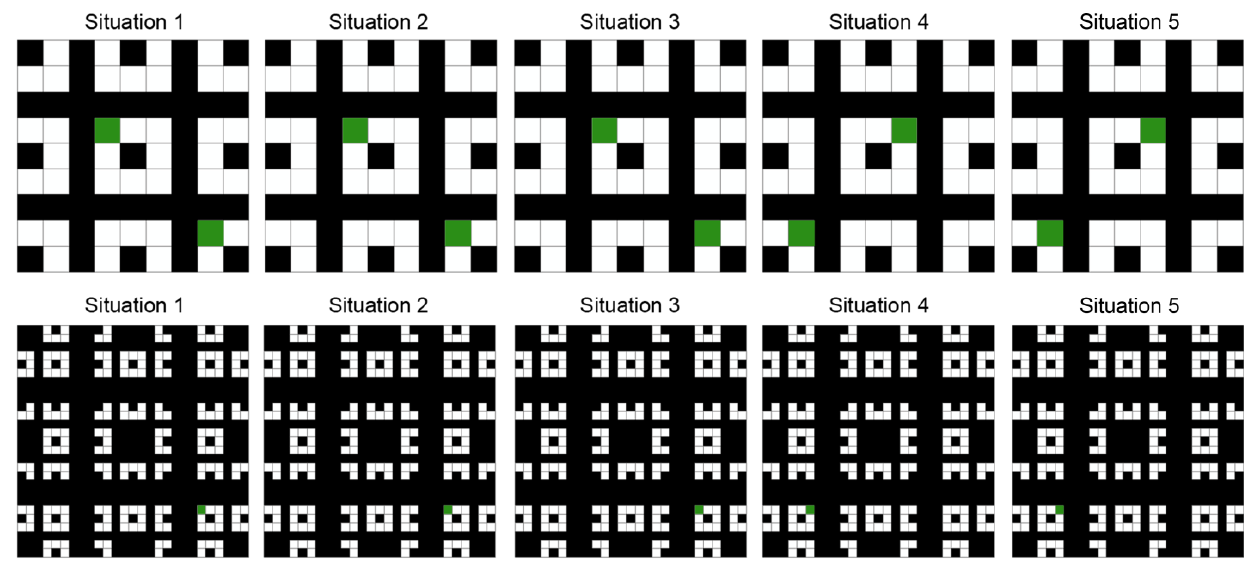
Figure 8. SESIs of lengths 2 and 3 for all of the